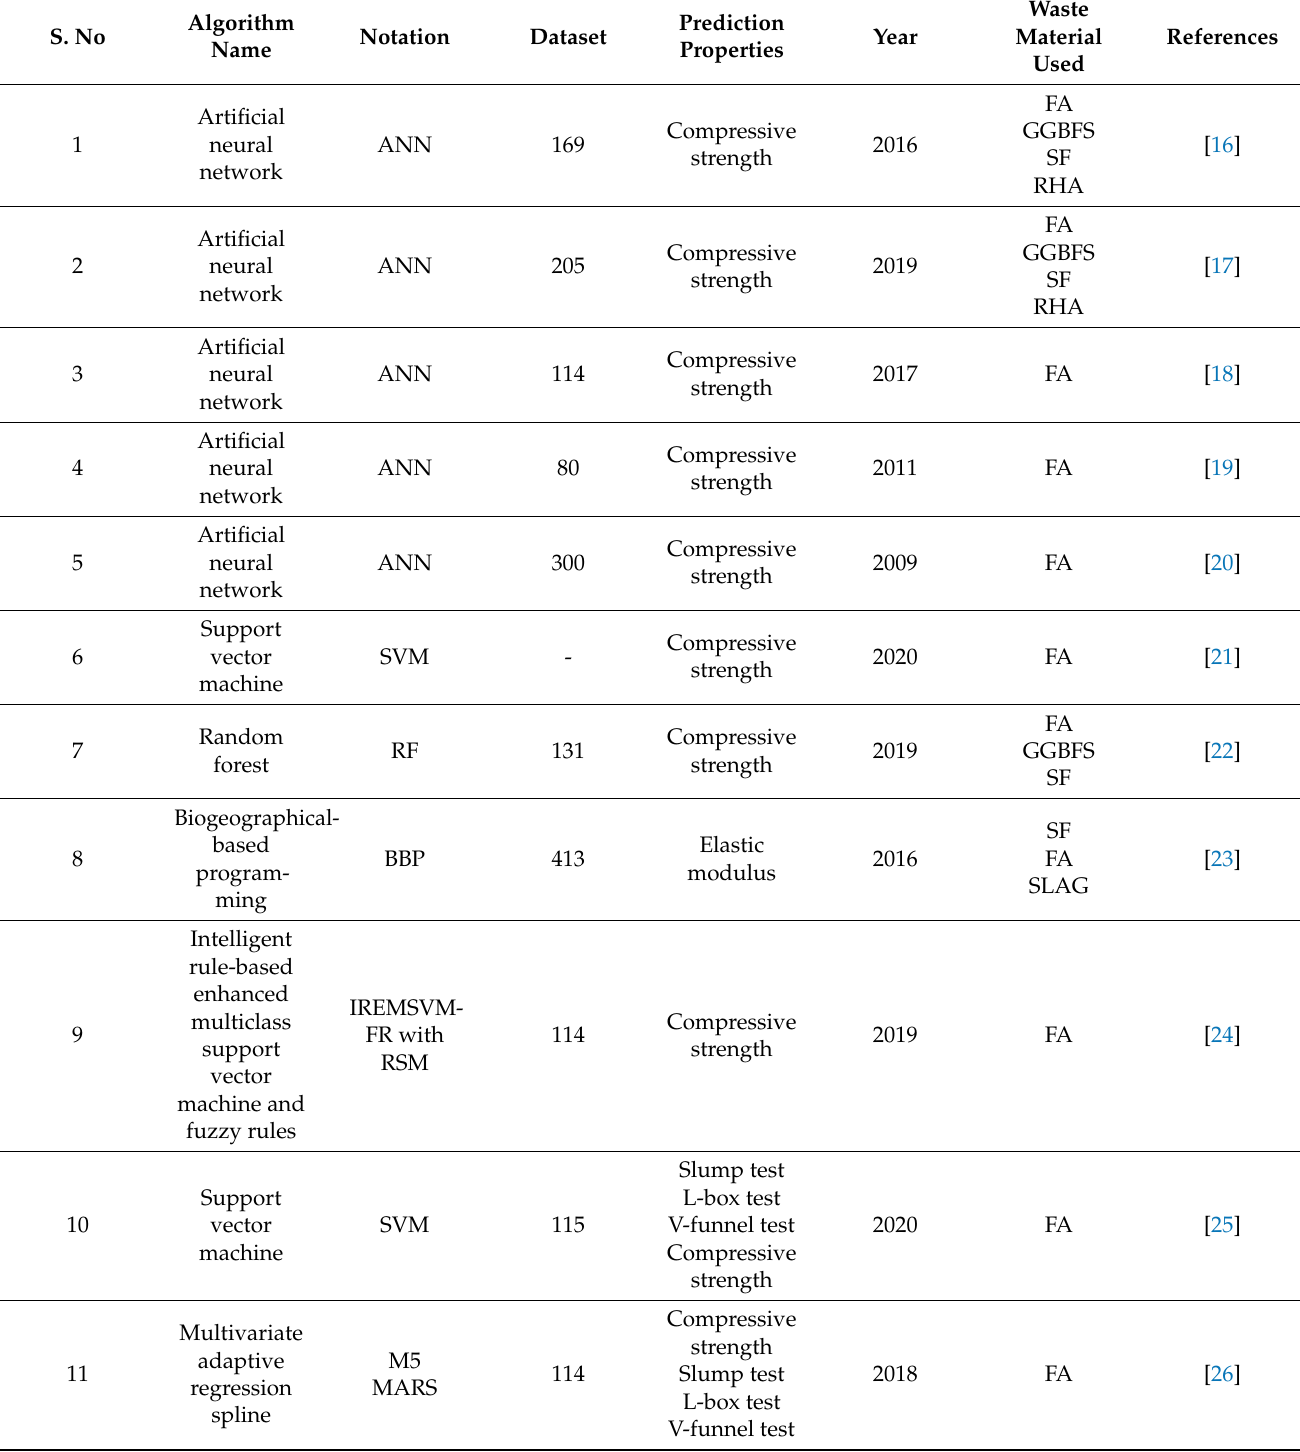
Table 1. The latest works in the subject of concrete compressive strength prediction.